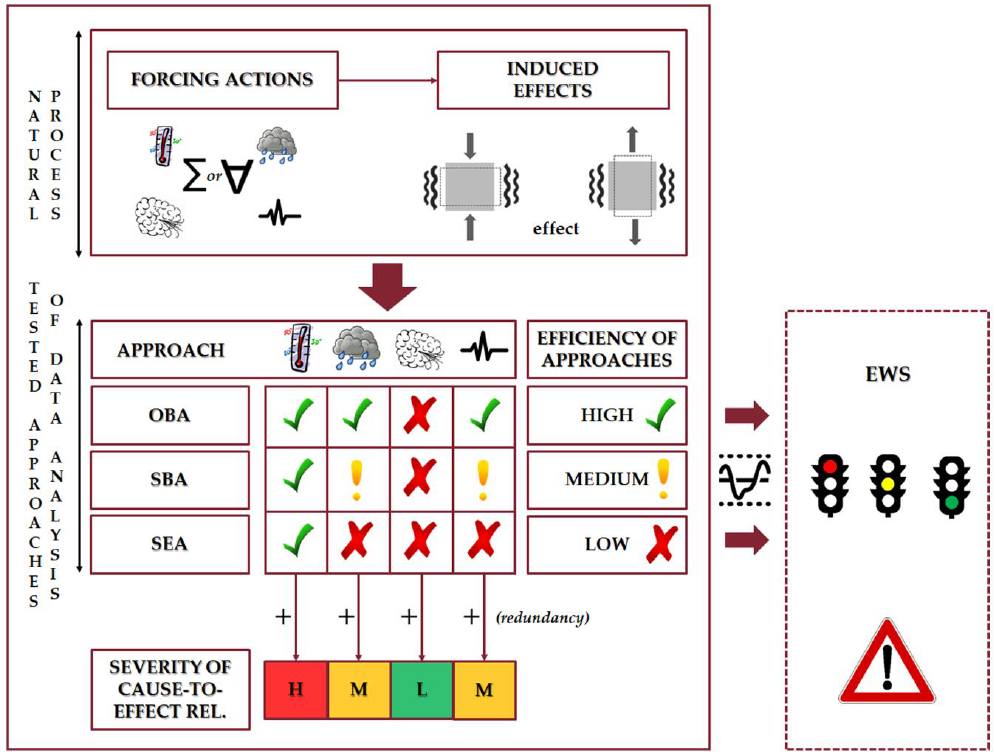
Figure 15. Flow chart illustrating the suitability of the compared approaches for data analysis based on the data recorded by the multi-parametric monitoring system installed at the Acuto test-site with the aim of mitigating the geological risk related to several destabilising actions which induce strain effects on the monitored rock-mass. The continuous-line box indicates the themes and activities carried out in the frame of this research. The dashed-line box indicates the future calibration of an early warning system based on the results of the compared